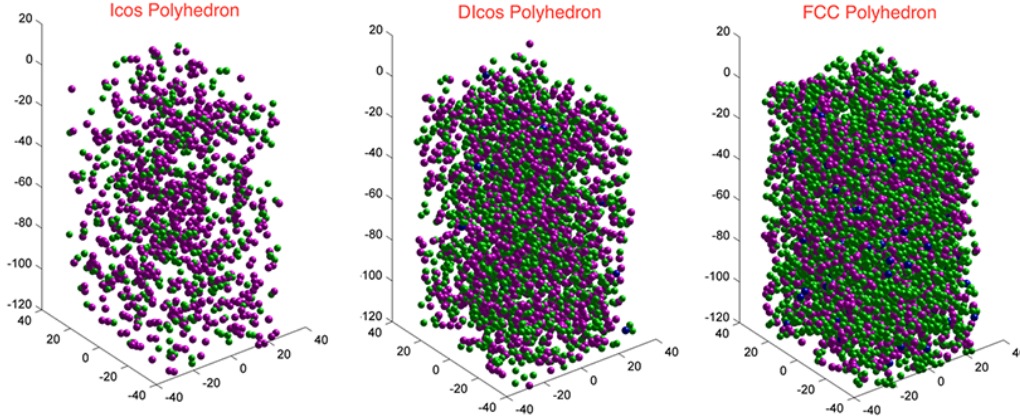
Zr Ti amorphous alloy at 300 K. Colorful spheres: 60.0 32.5 7.5